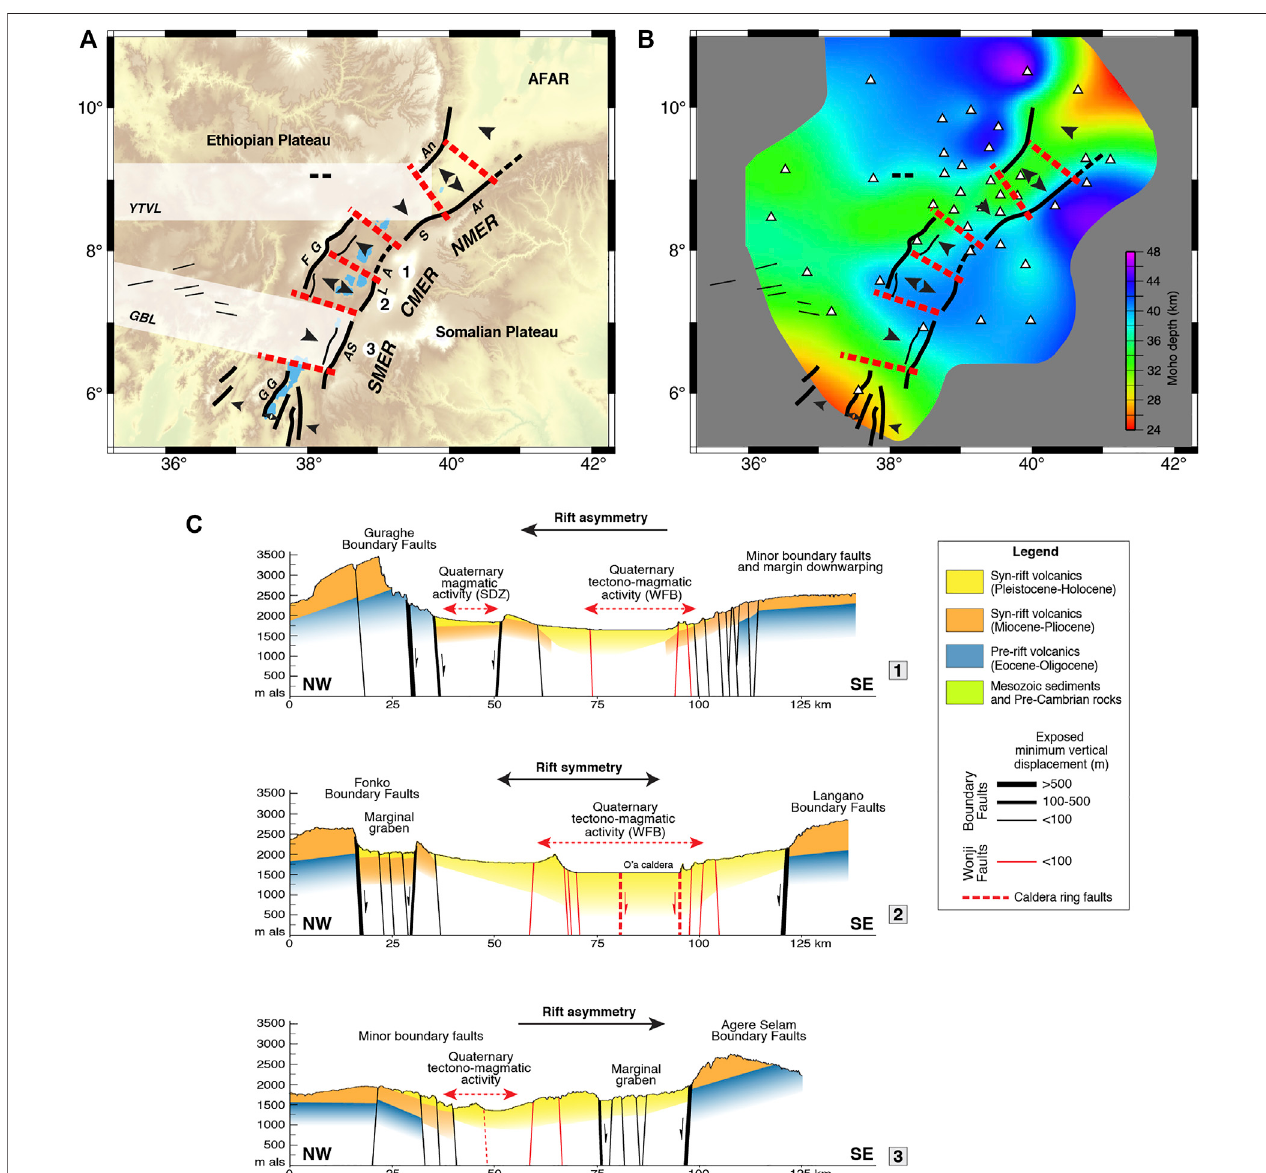
FIGURE5| Along-axisvariationsinthestructure oftheMainEthiopianRift(modi fi edfromCortietal.,2018a). (A) Interpreted variationsinriftsymmetryandpolarity: single arrows indicate the polarity of the different rift sectors; double arrows indicate symmetry of rifting. Whitish boxes indicate the hypothesised plan-view extent of the transversal structures: Yerer-Tullu Wellel (YTVL) and Goba-Bonga (GBL) volcano-tectonic lineaments. Rift segments labelled as NMER: Northern MER; CMER: Central MER, SMER: Southern MER. Other labels indicate the main rift escarpments as follows, An: Ankober; Ar: Arboye; AS: Agere Selam; FG: Fonko-Guraghe; GG: GamoGidole;LA:LanganoAsela;S:Sire. (B) MapofdepthoftheMohointheMER,modi fi edafterKeranenetal.(2009). (C) Simpli fi edgeologicalpro fi lesacrossdifferent sectors of the MER, with vertical exaggeration of x10. WFB: Wonji Fault Belt; SDZ: Silti Debre Zeit volcanic belt.